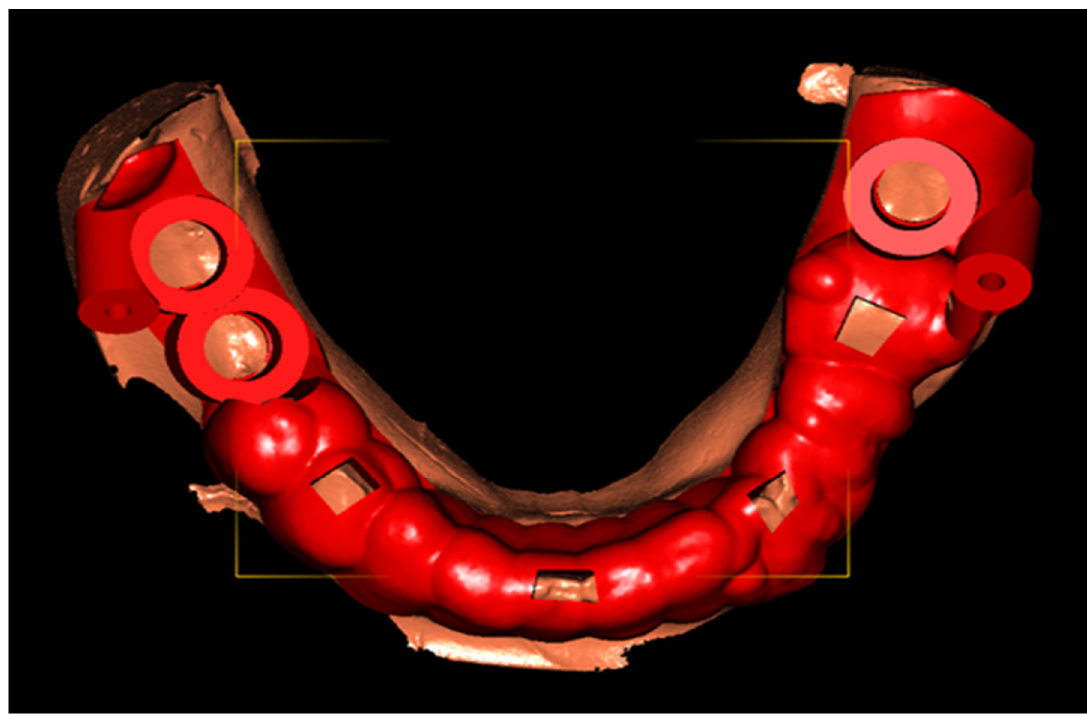
Figure 5. Guide design. Only diameters of the guide holes were changed in the designs for the OneGuide Kit (5.0 mm) and Guide Kit Taper (6.0 mm).